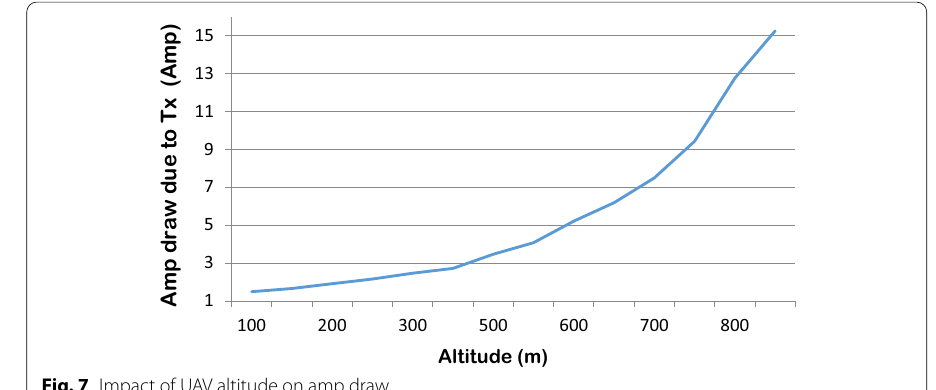
Fig. 7 Impact of UAV altitude on amp draw